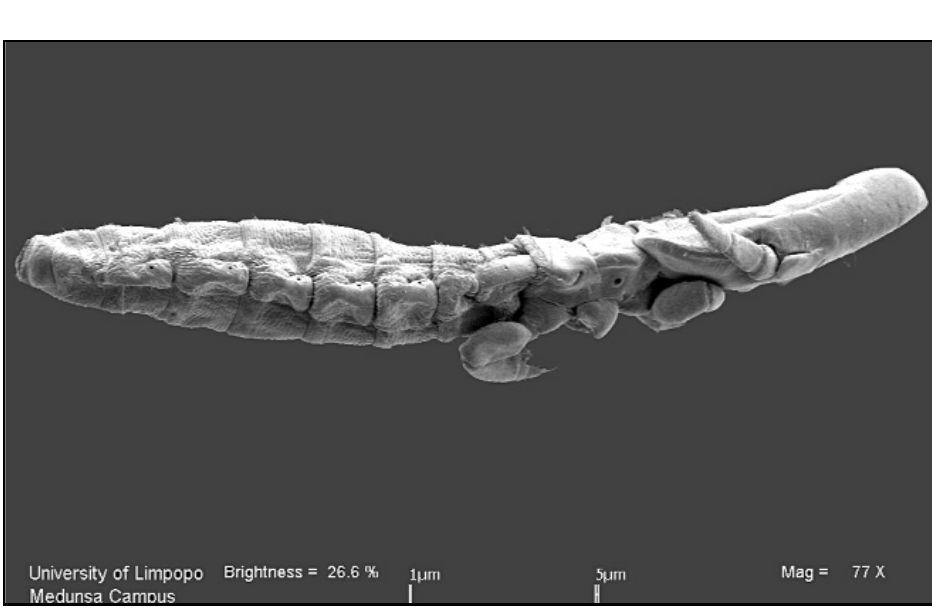
Fig. 1. A low magnification SEM micrograph of the lateral view D. antidorcus